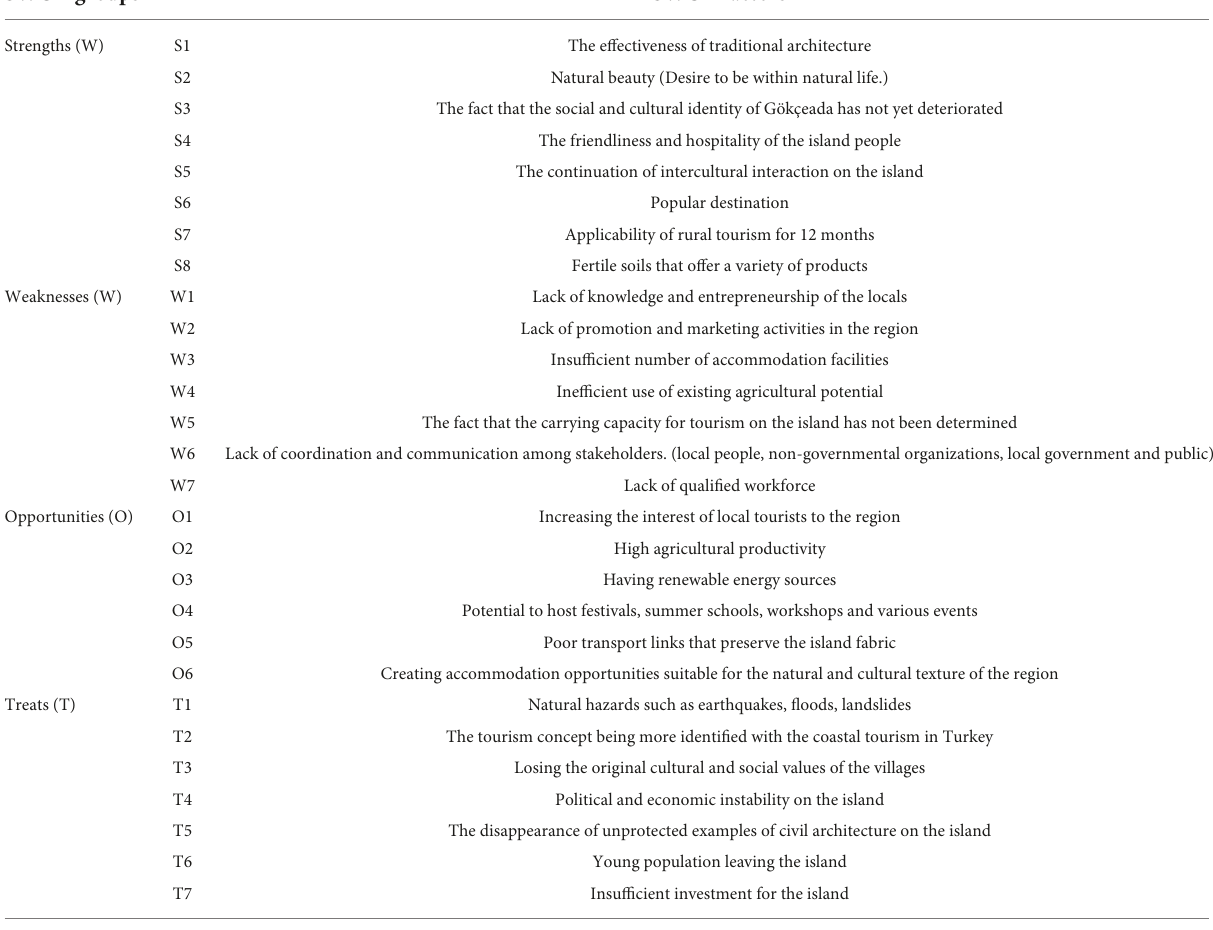
TABLE 2 SWOT factors of the Gökçeada in terms of sustainable rural tourism. SWOT groups SWOT factors